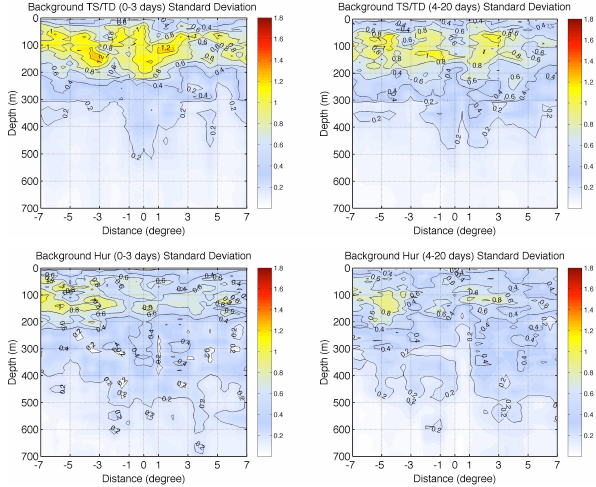
Figure B5. SD of the background footprints for TS/TD and hur- ricane locations, respectively, on two time periods: 0–3 and 4– 20 days. The unit is ◦